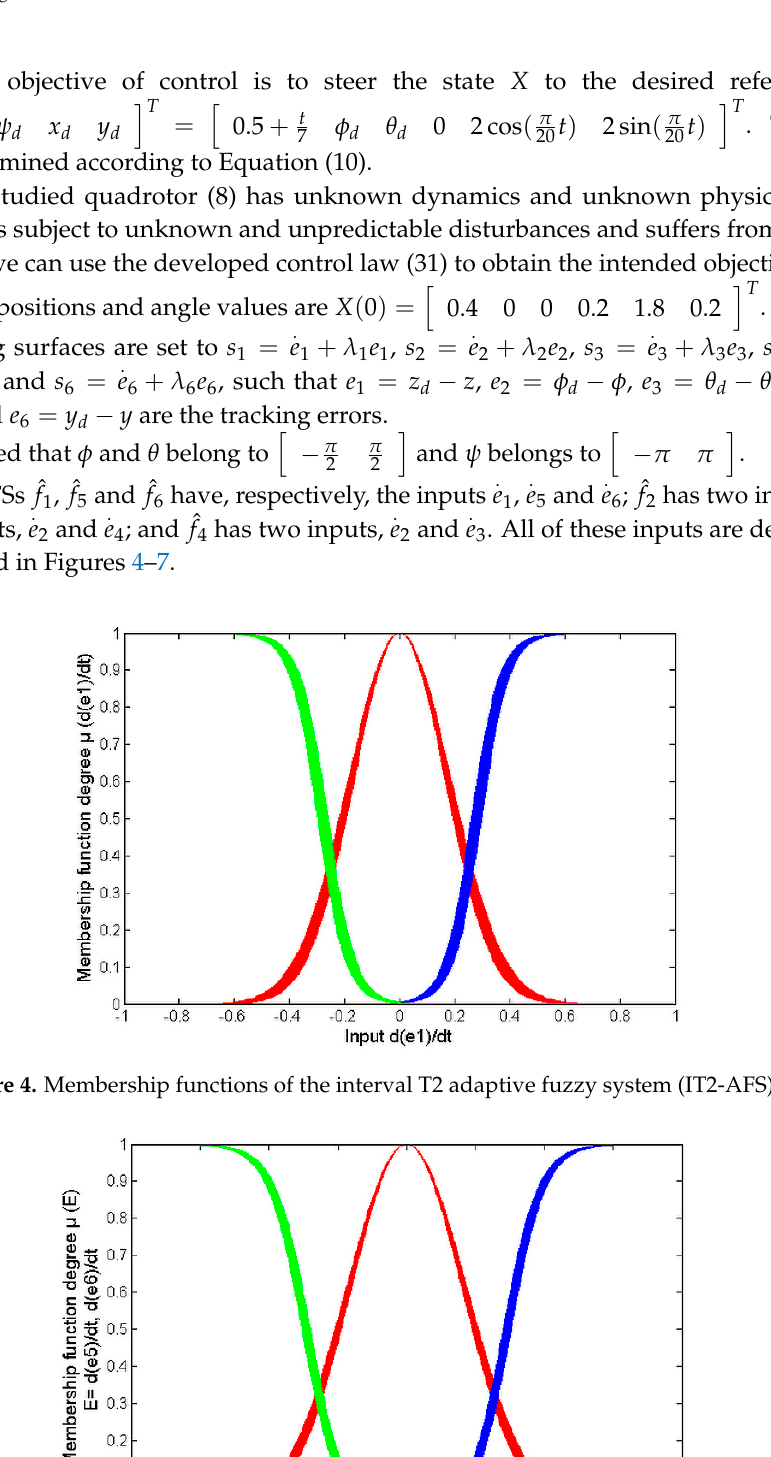
Figure 5. Membership functions of the IT2-AFSs